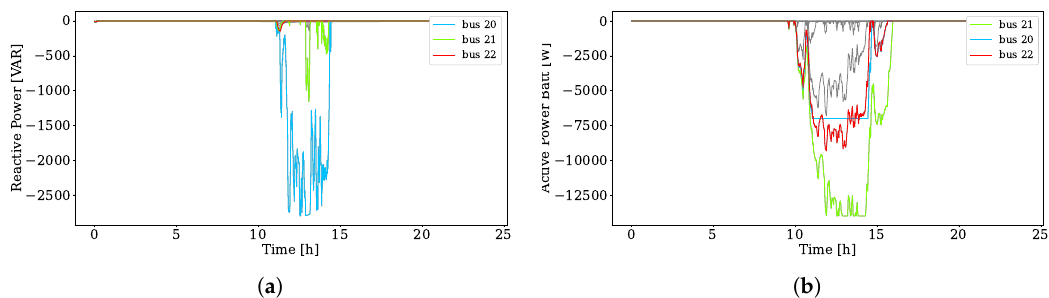
Figure 10. ESS power and DG energy production with prioritized use of the ESS over the DG. ( a ) Reactive Power generated by PVs. ( b ) Active power injected by ESSs.